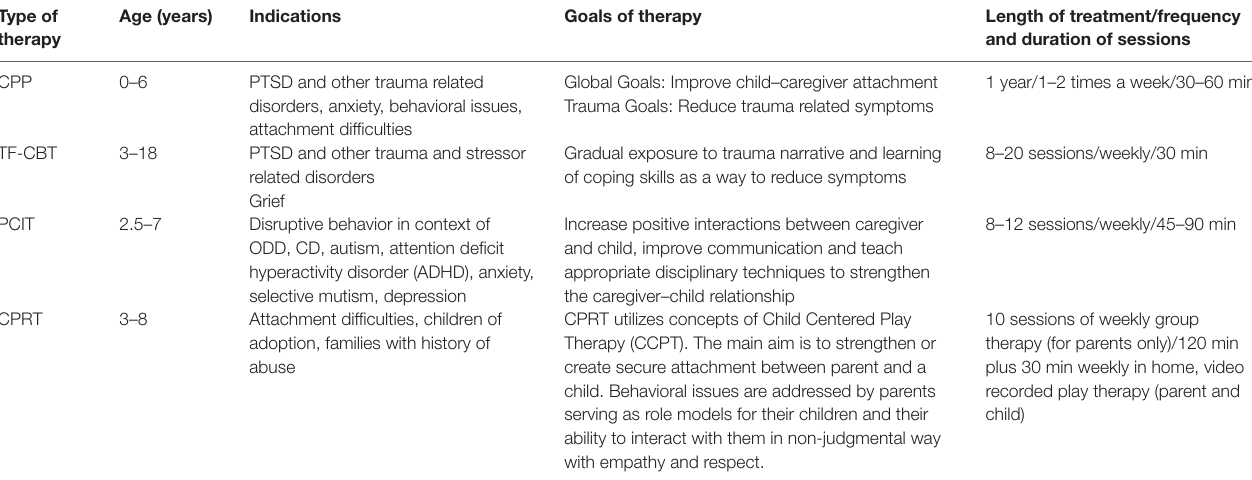
TABLE 3 | Summary of three main evidence-based psychotherapeutic interventions in young